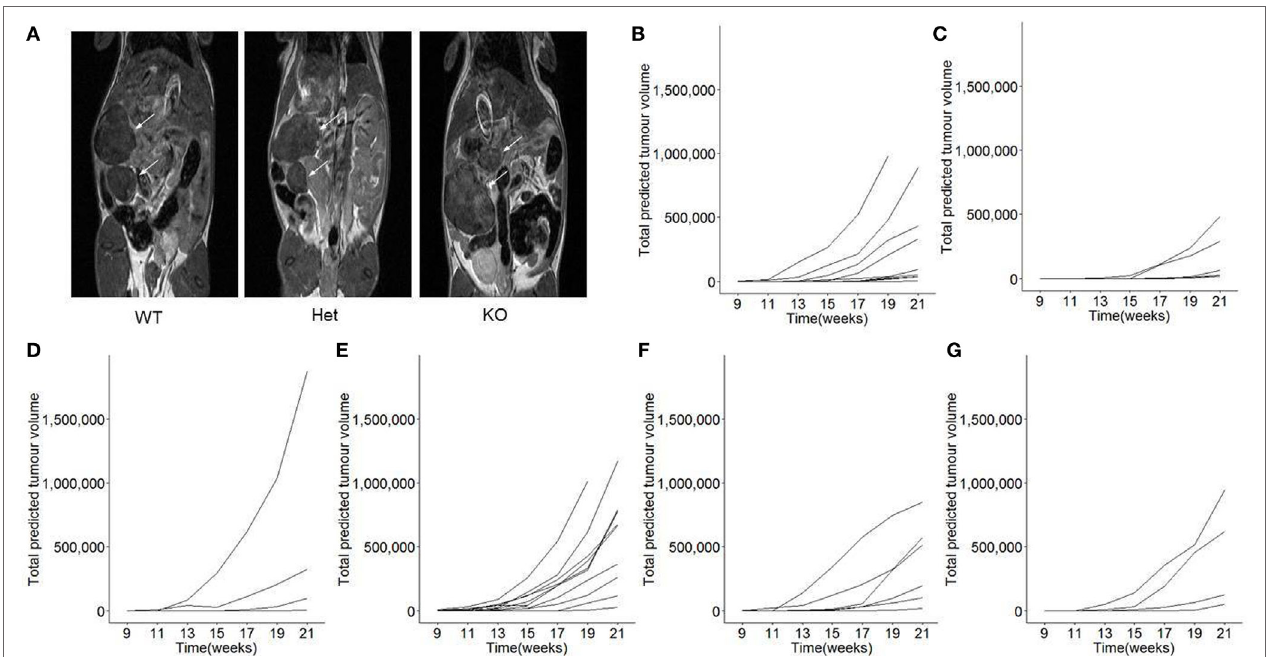
FigUre 2 | longitudinal monitoring of tumor growth in miR-342 knockout mice . TAg + , miR-342 + /0 TAg + , and miR-342 0/0 TAg + mice were monitored longitudinally by magnetic resonance imaging (MRI) for tumor load and size, from 7 weeks of age until 21 weeks of age. (a) Representative MRI images for each genotype. (B) Individual total predicted tumor volume curves for TAg + female mice ( n = 10), (c) miR-342 + /0 TAg + female mice ( n = 8), (D) miR-342 0/0 TAg + female mice ( n = 6), (e) TAg + male mice ( n = 13), (F) miR-342 + /0 TAg + male mice ( n = 6), and (g) miR-342 0/0 TAg + male mice ( n = 4).